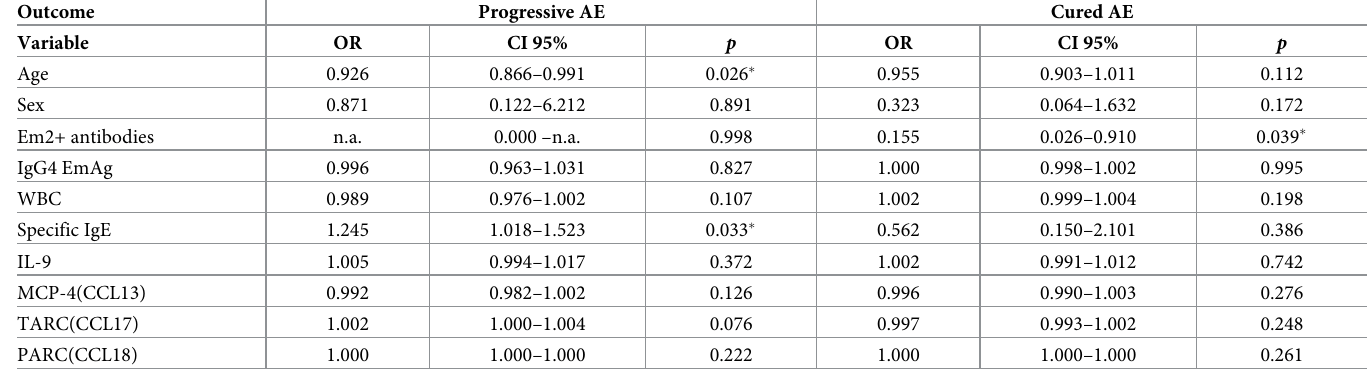
Table 11. Logistic regression models with variables associated with progressive or cured AE clinical status. OR = Odds, CI 95% = 95% confidence interval, p = signifi- cance level with � considered significant.